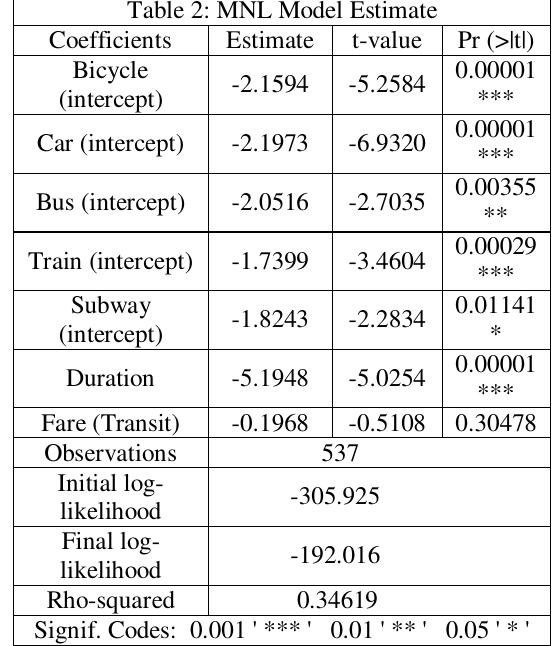
Table 2: MNL Model